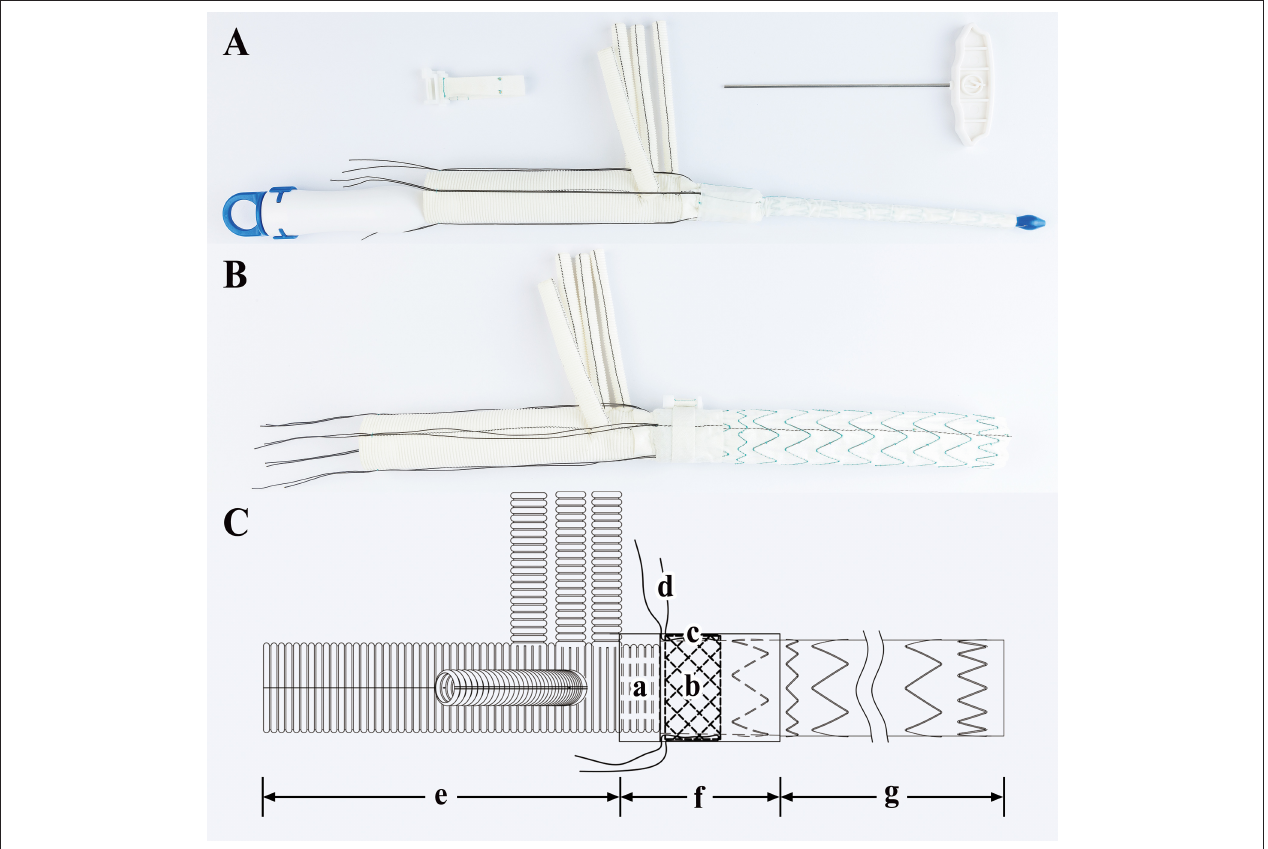
FIGURE 1 | Sutureless Integrated Stented (SIS) graft prosthesis . (A) Real product image of the SIS graft prosthesis before release: a, Delivery system; b, Vascular graft; c, Sutureless belt; d, Wrench. (B) Real product image of the SIS graft prosthesis after release. (C) Design drawing of the SIS graft prosthesis: a, Terylene vascular graft with screw threads; b, Sutureless elastic support annulus; c, Terylene without screw threads; d, Restraint sutures; e, Terylene vascular graft region; f, Sutureless region; g, Stented-graft